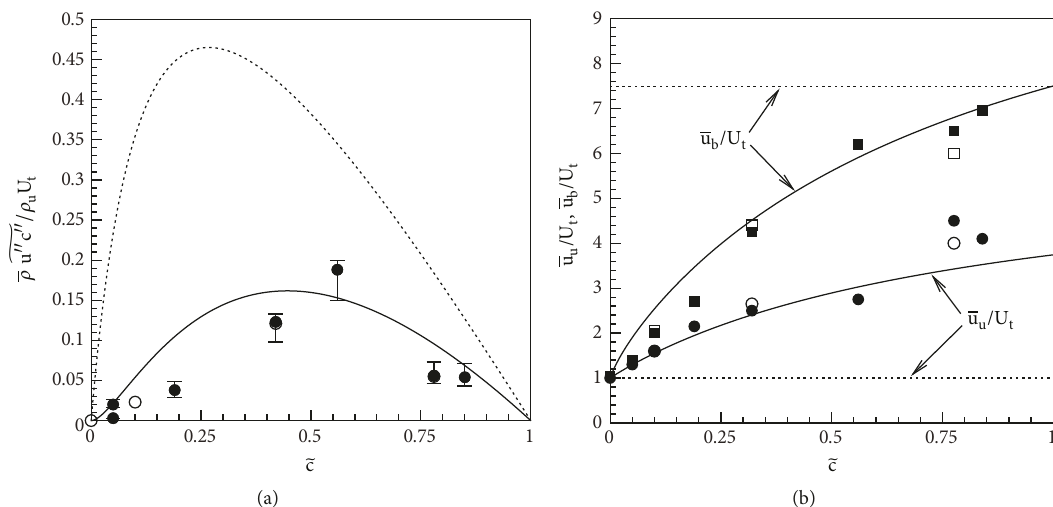
Figure 3: Comparison of theoretical results for the dimensionless scalar flux and conditional mean velocities (solid curves) with Moss’s experimental data [13] (the marks) for a fixed section of a turbulent Bunsen